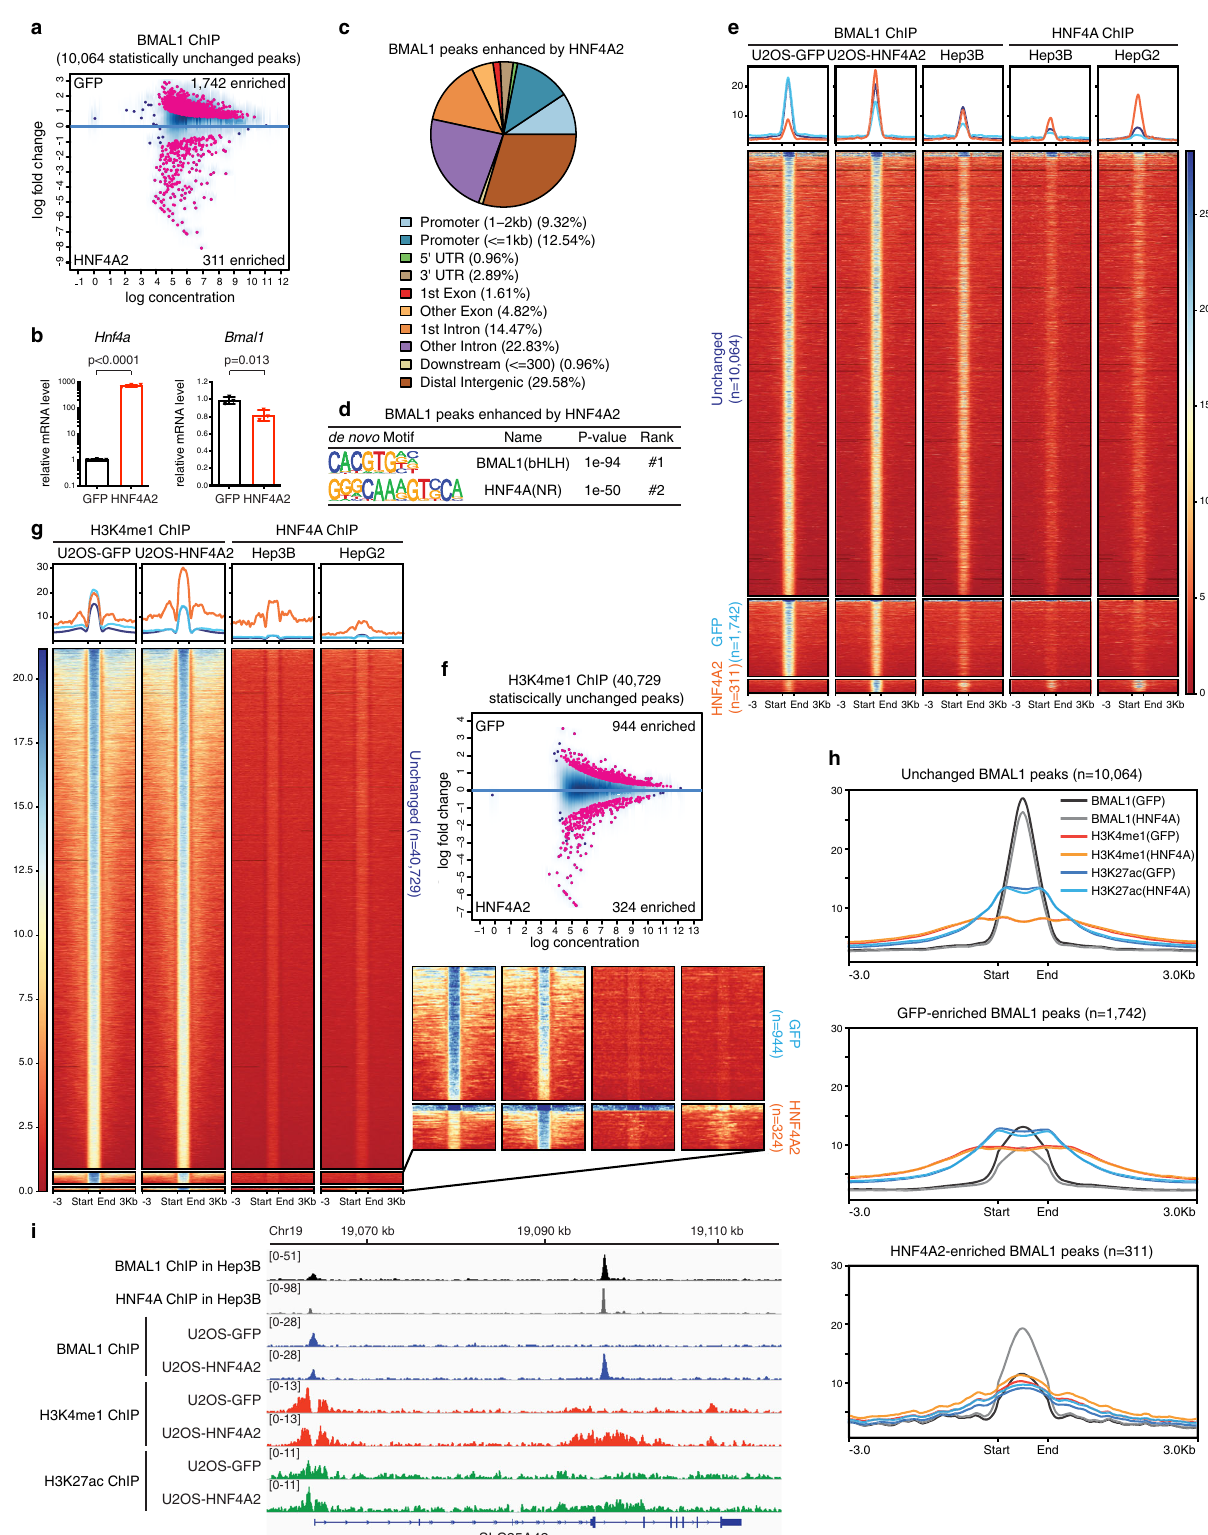
Ectopic HNF4A expression reprograms epigenetic landscape and induces tissue-speci fi c BMAL1 bindings . Next, we sought to assess BMAL1 cistromes before and after HNF4A action in a biological system that has never been exposed to HNF4A protein. We ectopically expressed the adult isoform HNF4A2 in human bone osteosarcoma epithelial U2OS cells where the endogenous NATURE COMMUNICATIONS| (2021) 12:6350